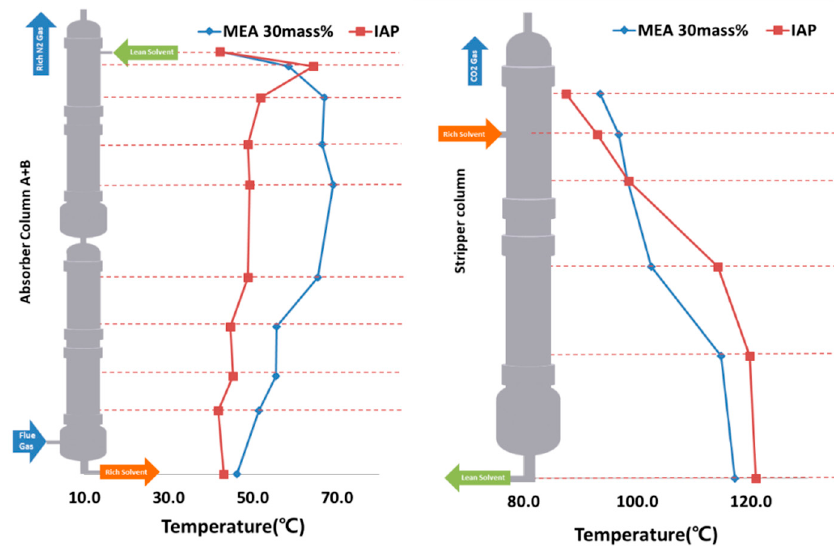
Figure 7. Temperature profiles in the absorber and stripper columns under the optimum operating conditions for MEA and IAP .